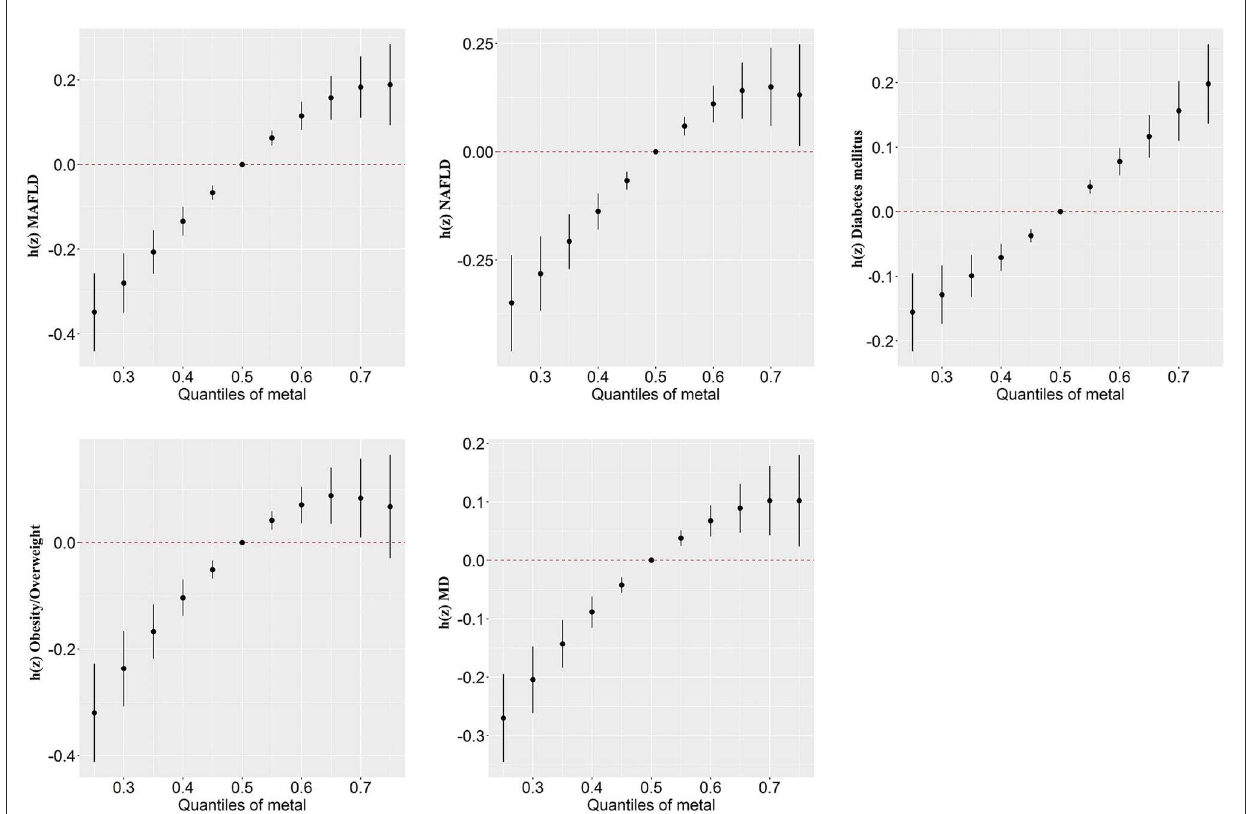
FIGURE2 Combined association (95%CI) of metal mixture with MAFLD, NAFLD, and components of MAFLD by BKMR models, comparing all chemicals set at different levels with their 50th percentiles. Models were adjusted for age, gender, race, research cycle, education level, smoking status, poverty income ratio, and physical activity. BKMR, Bayesian kernel machine regression; MAFLD, metabolic associated fatty liver disease; NAFLD, non-alcoholic fatty liver disease; MD, metabolic